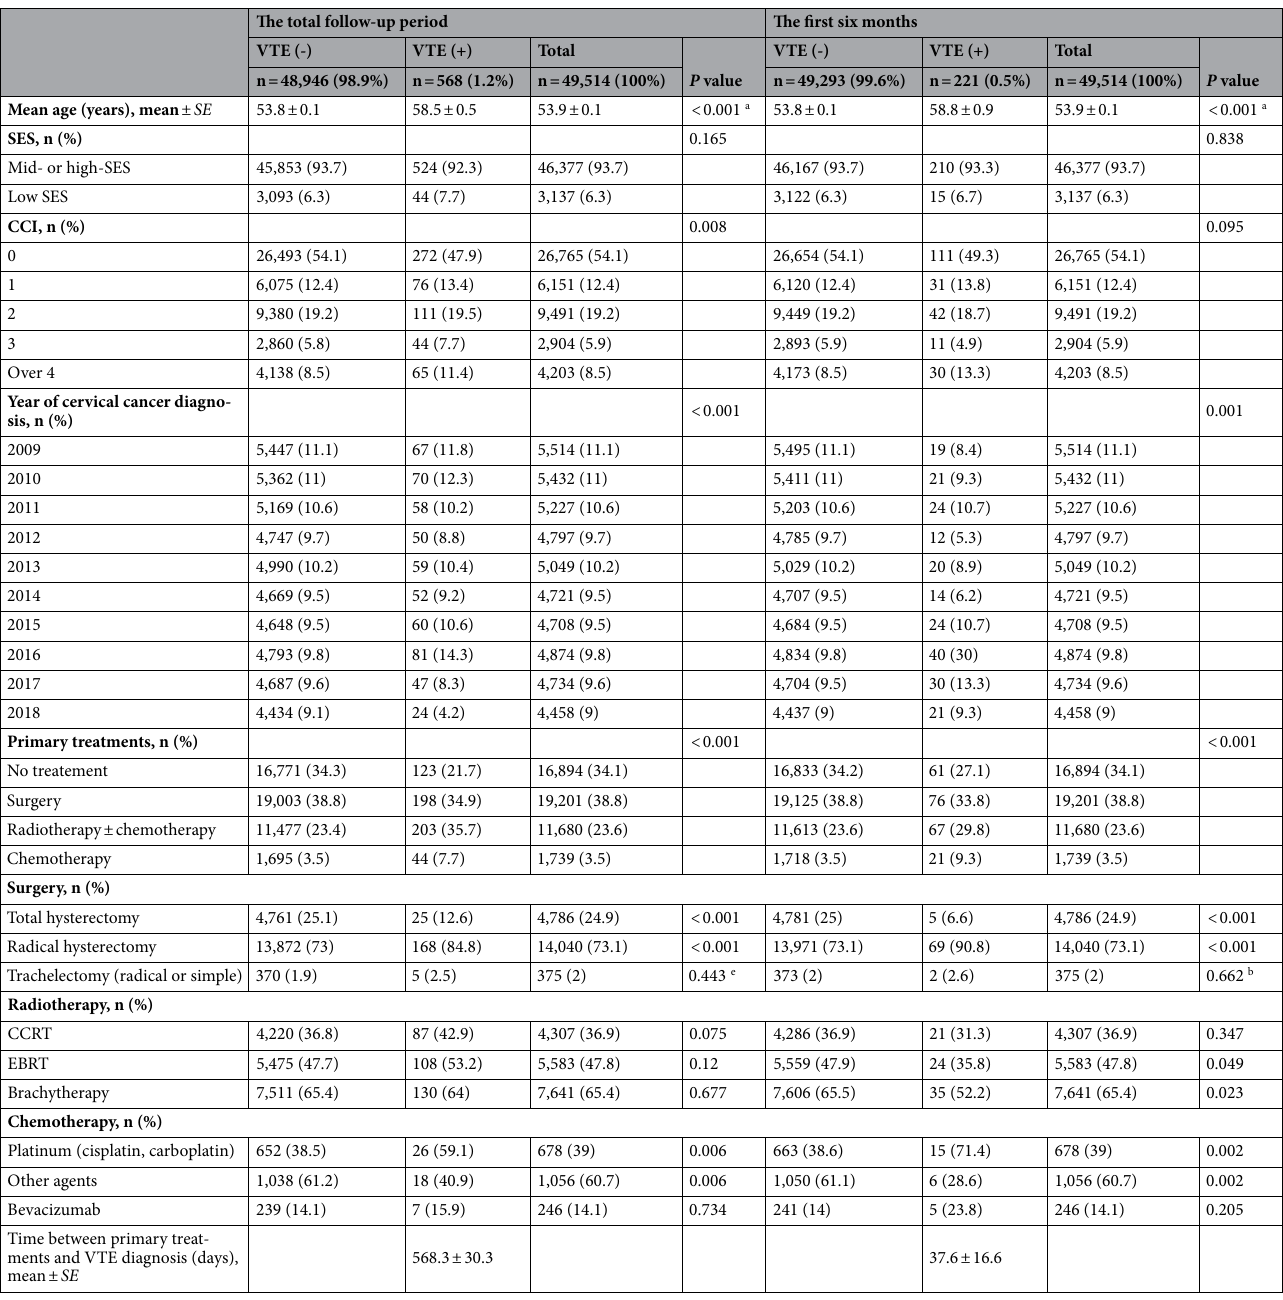
Table 1. Characteristics of patients with cervical cancer in HIRA claims data of 2009–2018. CCRT concurrent chemoradiation therapy, EBRT external beam radiation therapy, SE standard error. a The Mann–Whitney U test was used for this analysis. b The Fisher’s exact test was used for this